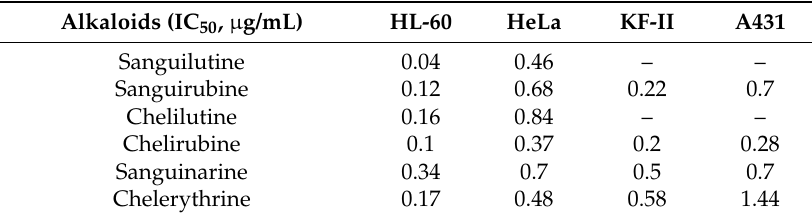
Table 1. Comparison of the cytotoxicity of major and minor QBA (IC 50 ) [155,157]. Alkaloids (IC 50 , µ g/mL) HL-60 HeLa KF-II